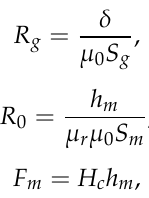
Figure 7. Unit magnetic circuit principle: ( a ) electromagnetic drive unit equivalent magnetic circuit; ( b ) electromagnetic drive unit equipment electric circuit; ( c ) VCM equivalent diagram.